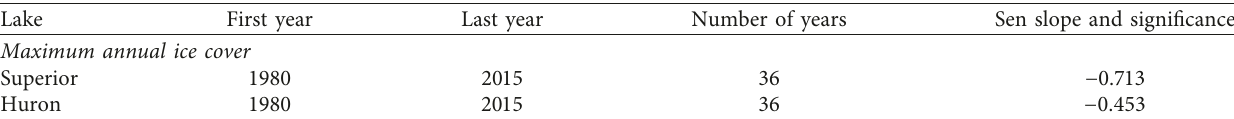
Table 5: Maximum annual ice cover trend analysis for Lakes Superior and Huron with corresponding years used in Sen slope calculation.